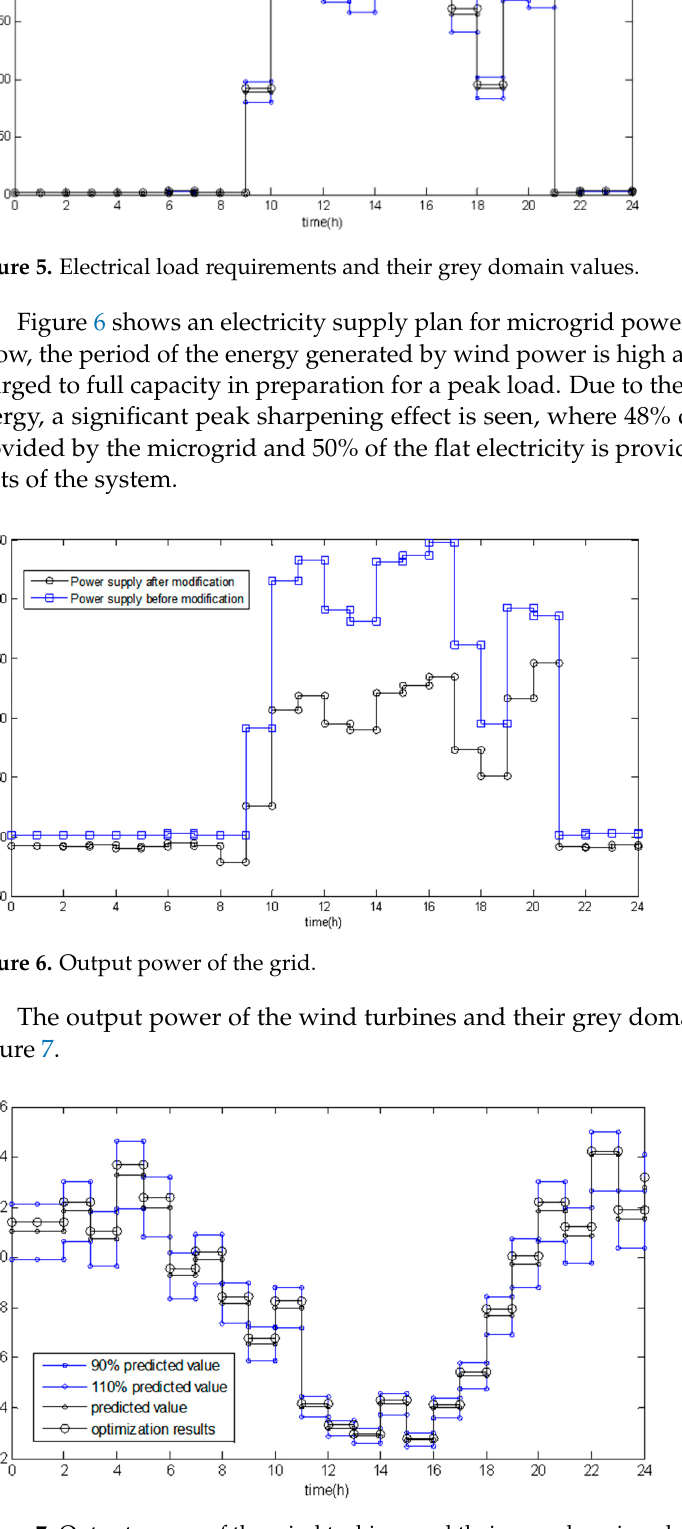
Figure 7. Output power of the wind turbines and their grey domain values. The output power of the photovoltaic cells and their grey domain values are shown in Figure 8. Figure 8. Output power of the photovoltaic cells and their grey domain values.